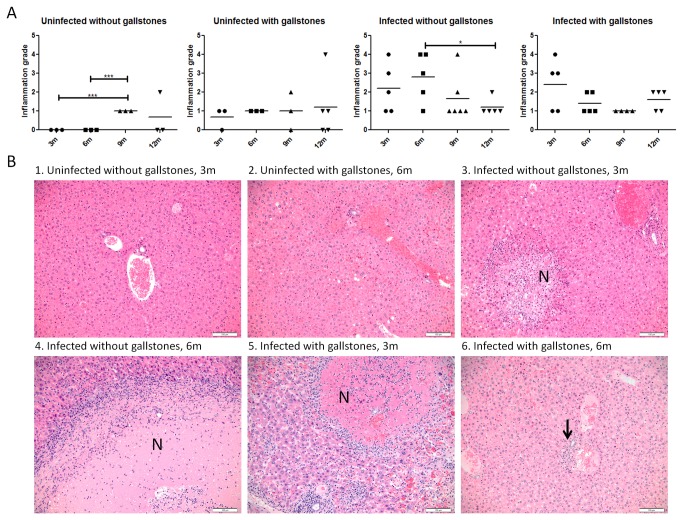
Chronic hepatitis is exacerbated in infected mice at 3 and 6 months post-infection.(A) Inflammation grades in the liver at all time points post-infection (± bacteria, ± gallstones). Means of each time point values were compared by a Student’s t test (*, p<0.05; ***, p<0.001). (B) Representative HE images of each group at 3 and 6 months post-infection. Inflammation scores are as follows: B1 (0); B2 (1); B3 and B6 (2); B4 and B5 (4). Infected mice have scattered inflammatory cells distributed randomly within the lobule (B3-B5) and/or in portal areas (B6) composed of neutrophils, lymphocytes, plasma cells and histiocytes. Inflammation was often associated with necrosis of individual hepatocytes (B3) or large confluent areas of hepatocellular necrosis (B4-B5) (noted as N). 20x.